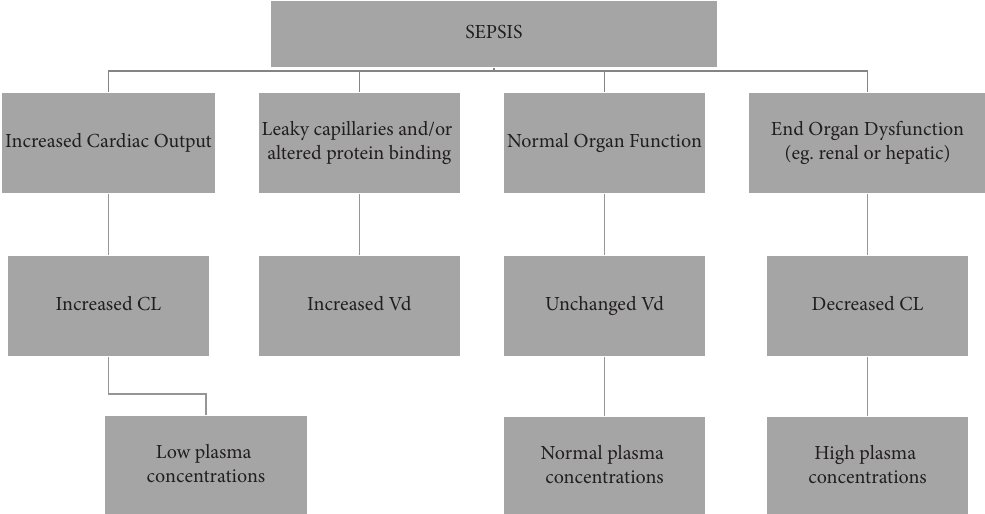
Figure 3: Diagrammatic view of pathophysiological variations that can happen during sepsis and their pharmacokinetic consequences. CL: clearance; Vd: volume of distribution. Modifed from Roberts and Lipman [9].